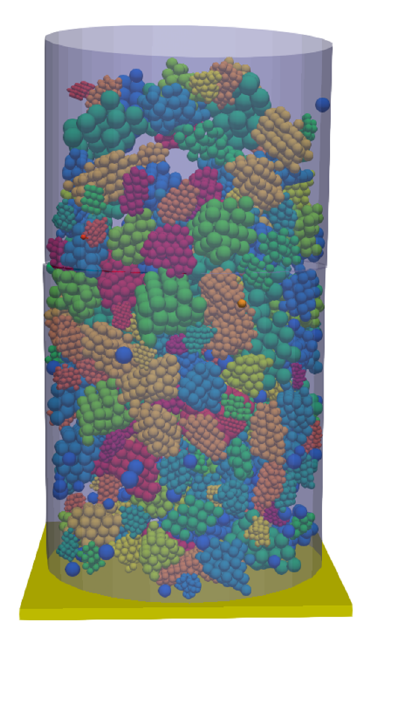
Figure 6. Clump models.